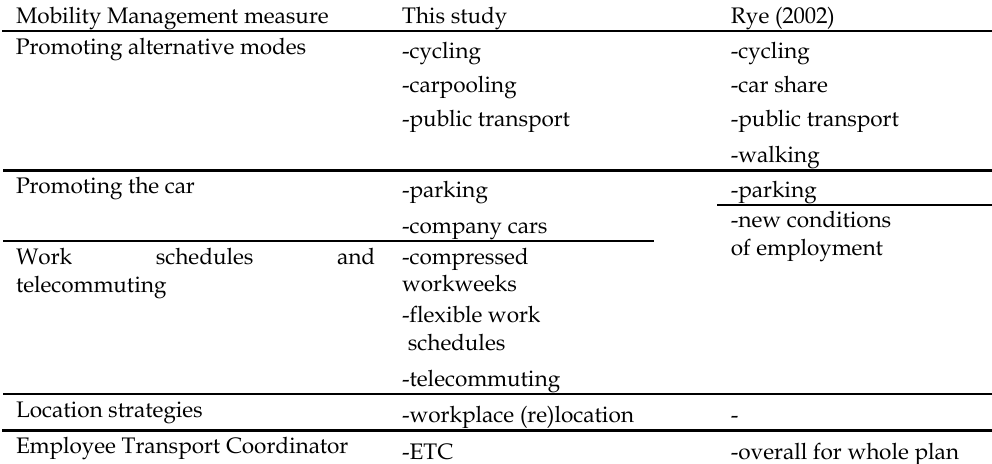
Table 1. Overview of employer initiatives that influence employee travel